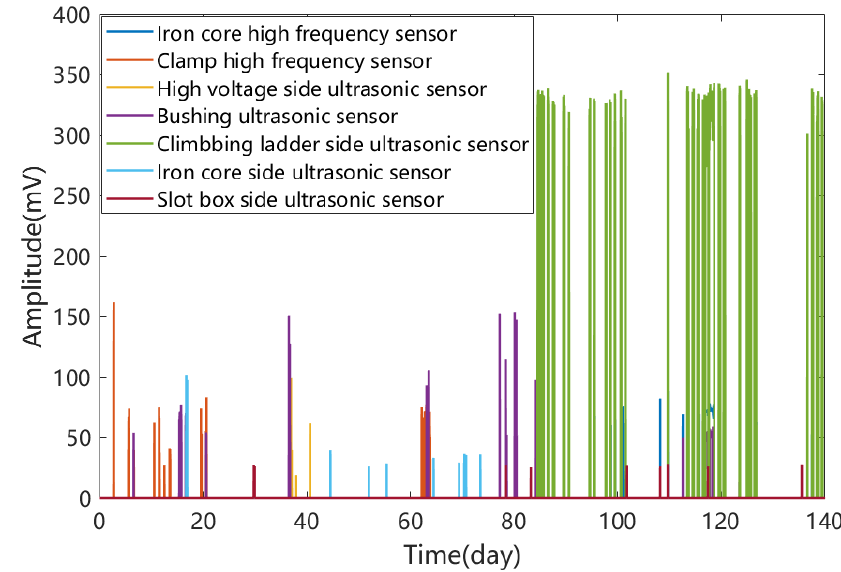
Figure 8. Adaptive filtering results of pulse current and ultrasonic sensor data.